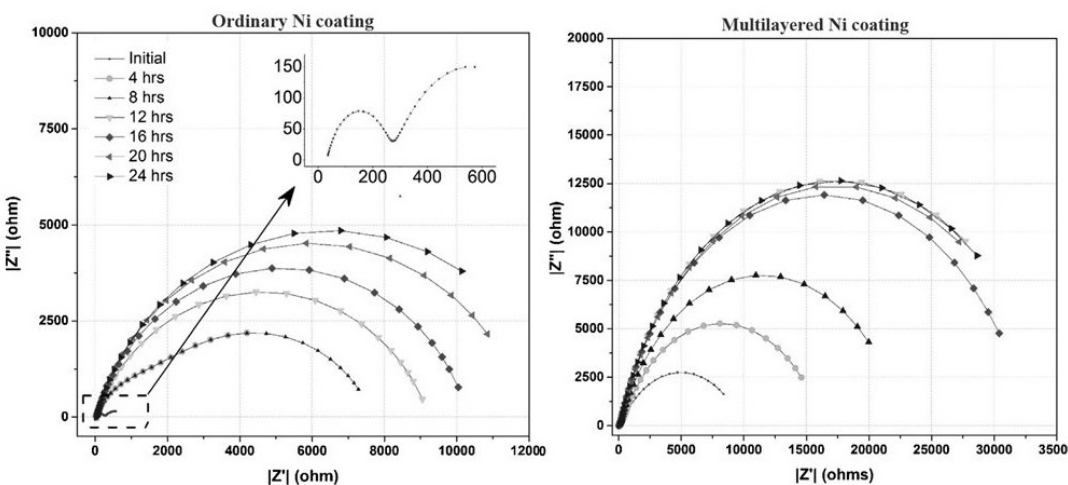
Figure 4. Nyquist plots of ordinary Ni coating and multilayered Ni coating in 3.5% NaCl solution for immersion time more than 24 h at 298 K.